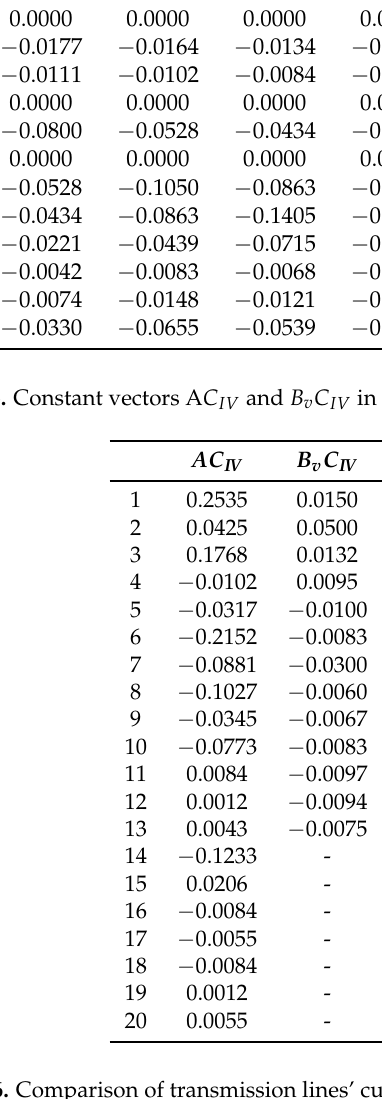
Table 6. Comparison of transmission lines’ current